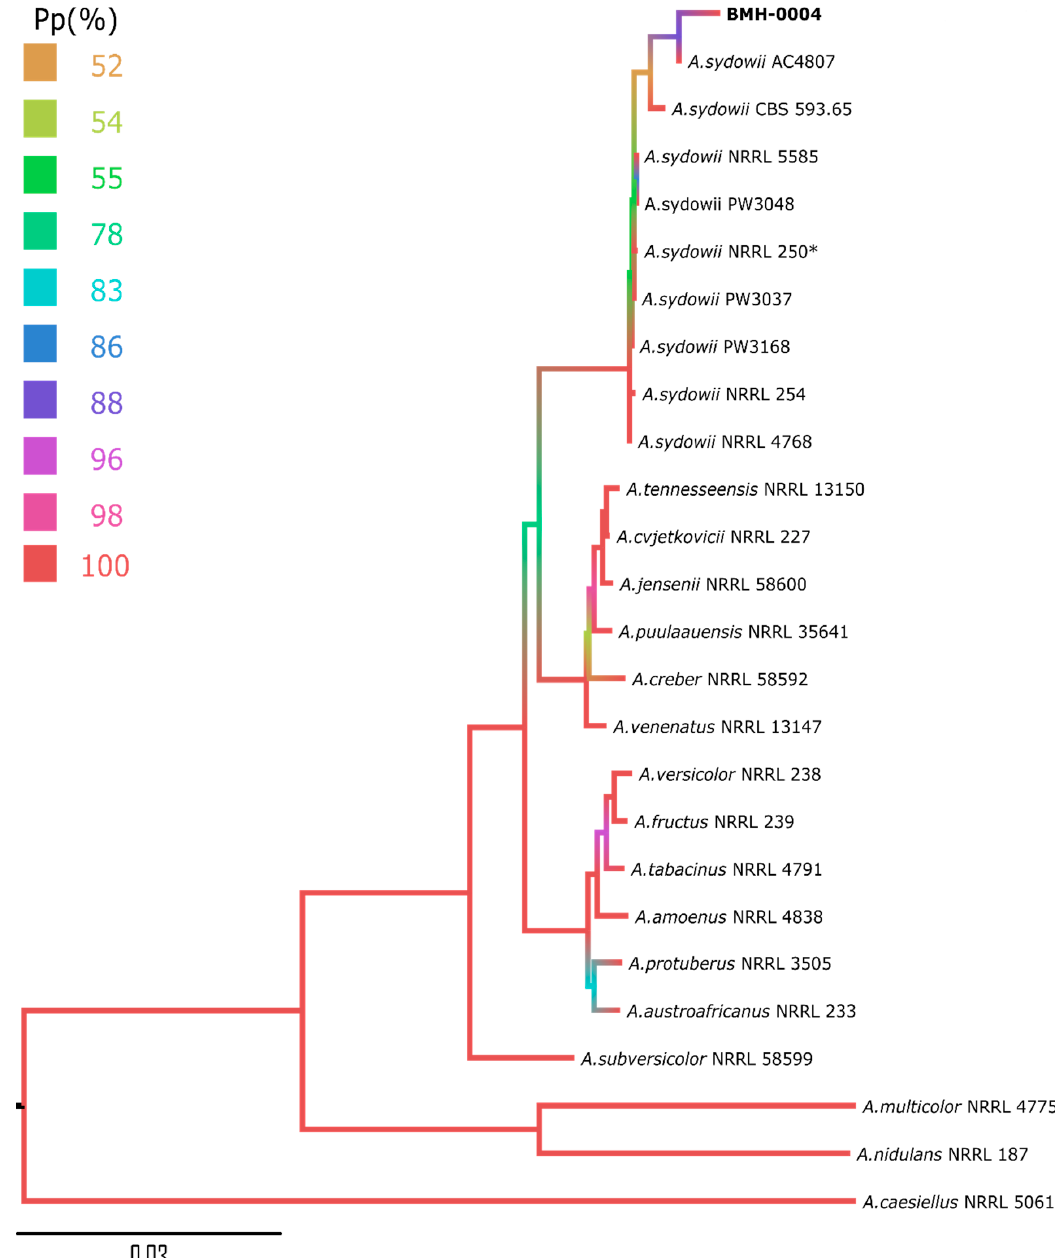
Figure 1. Bayesian phylogram obtained based on the concatenated alignment using an internal transcribed spacer (ITS), benA , cam, and rpb2 from strains belonging to Aspergillus section Versicolores [44]. The color of the branch corresponds to the posterior probabilities (Pp) percentage. The accession number of the genes used for the phylogram is given in Supplementary Table S1. * Aspergillus sydowii reference strain [21].